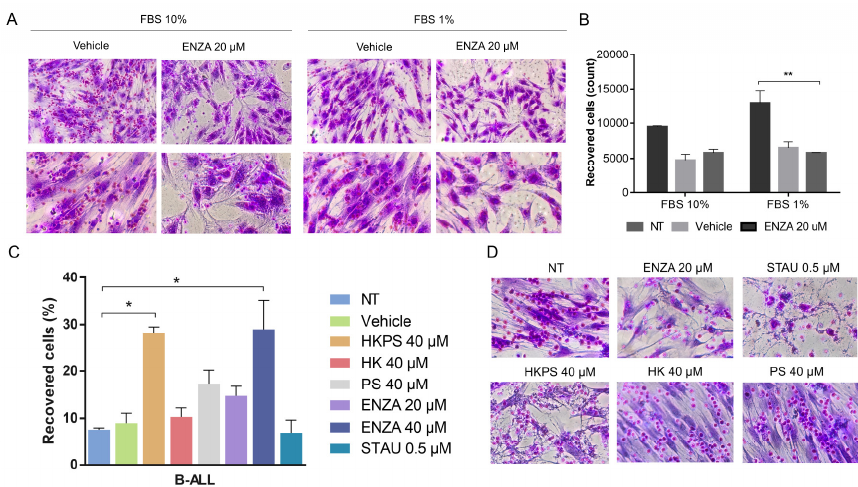
Figure 4. HKPS reduces the adhesion capacity of the B-ALL cells to MSC. ( A ) MSC were treated for 2 h with the PKC inhibitor ENZA or the vehicle (DMSO 0.4%) in co-cultures with B-ALL cells for 6 h at different FBS concentrations. Microphotographs show adherent B-ALL cells to the MSC support stained with crystal violet. Representative microphotographs are shown at 10 × and 20 × magnification. ( B ) B-ALL cells were recovered by washing with PBS 1 × and counted using a hemocytometer. ( C ) MSC were treated as indicated and the percentage of leukemic cells recovered was calculated based on the input of the B-ALL cells and the cells present in the supernatant after washing the co-cultures with PBS 1 × . ( D ) Adherent cells in the co-cultures were stained with crystal violet after removing the non-adherent B-ALL cells. Representative microphotographs are shown at 20 × magnification. Data are expressed as mean ± SEM ( p values: nonparametric one-way ANOVA * p < 0.05. ** p <